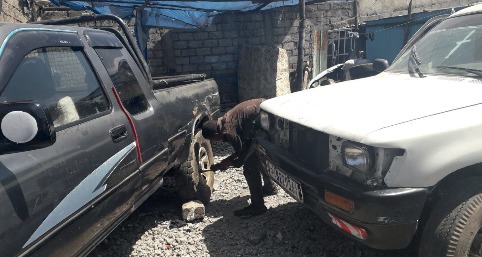
A vehicle repair worker exerting high force to manually tighten the wheels of a vehicle.